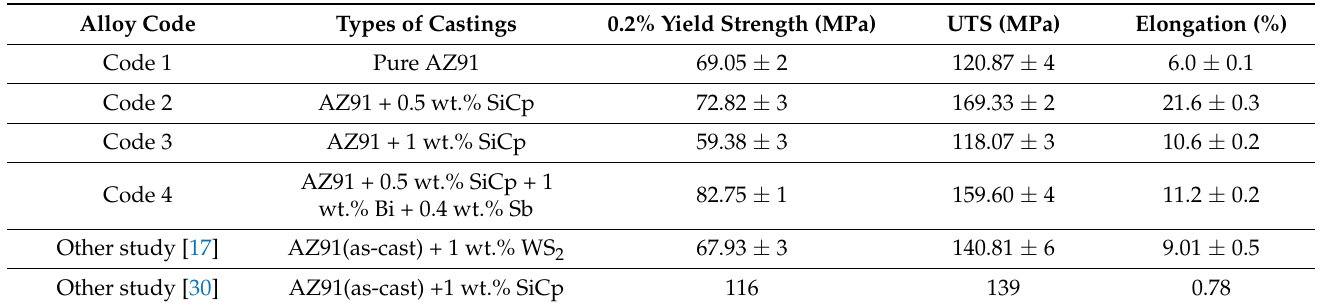
Figure 4. Engineering stress–strain curve for AZ91 alloy composites with different hybrid nano- and micro-reinforcements. Table 4. Tensile properties of pure AZ91 and AZ91 composites with different hybrid nano- and micro-reinforcements.